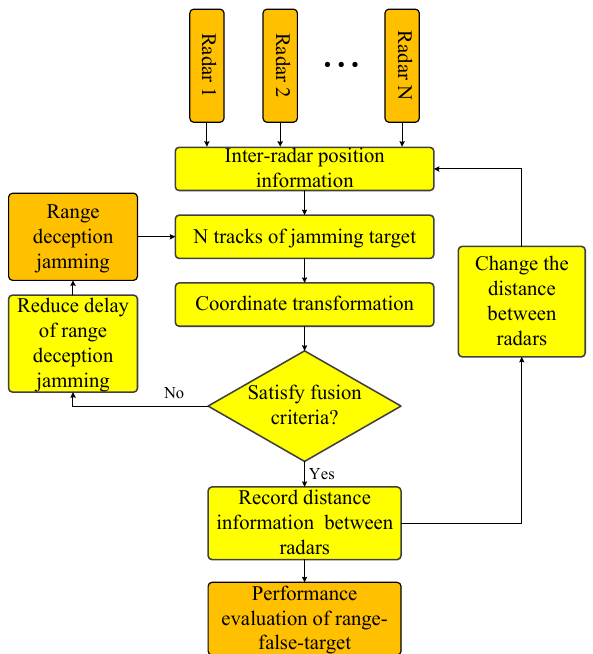
Figure 6. Flowchart for the jamming performance evaluation.